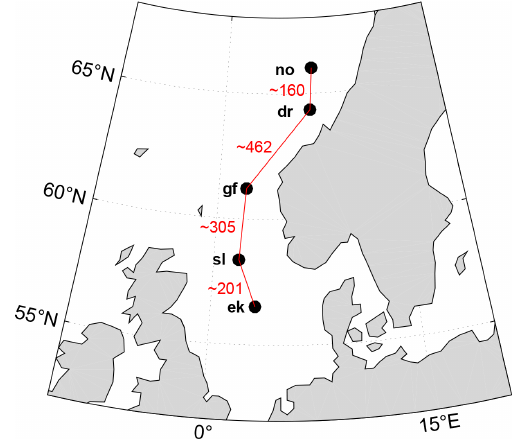
Figure 1. Position of the five sites and the distance (km) between them (red lines). Abbreviations are as follows. ek: Ekofisk; sl: Sleip- ner; gf: Gullfaks C; dr: Draugen; no: